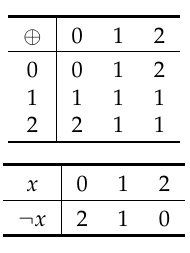
Table 5. Operations tables for the independence of ( MV 5 )